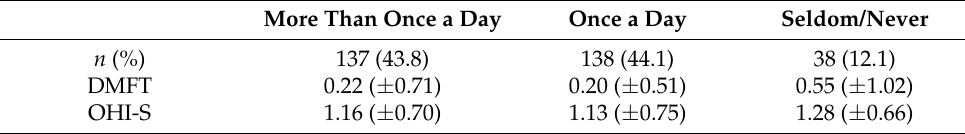
Table 5. Mean DMFT and OHI-S in relation to the frequency of toothbrushing.